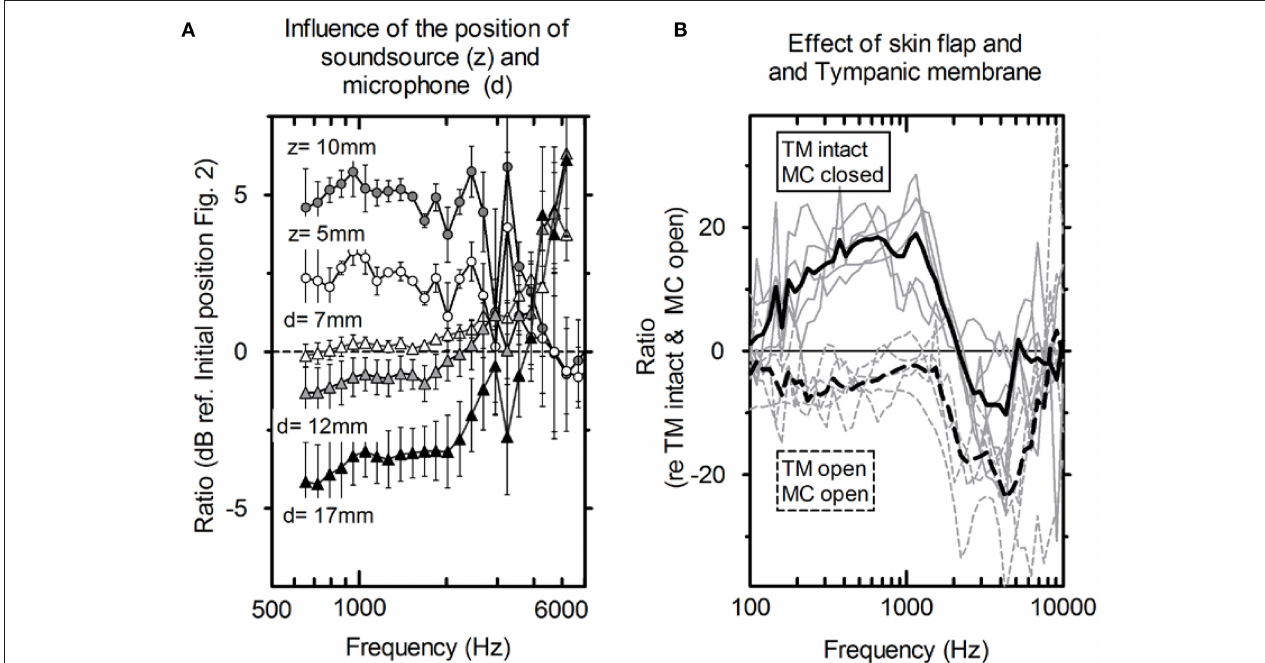
FIGURE 3 | (A) Average influence of the distance of the microphone to the tympanic membrane (circles, n = 5) and actuator position toward the depth of the mastoid cavity (triangles, n = 5) and the standard deviation. (B) P EAC variations. Solid lines: mastoid cavity (MC) closed with skin flap and intact tympanic membrane (TM); dashed lines: mastoid cavity (MC) open and tympanic membrane is elevated (TM); gray lines: individual measurements; black lines: averaged ( N = 5).